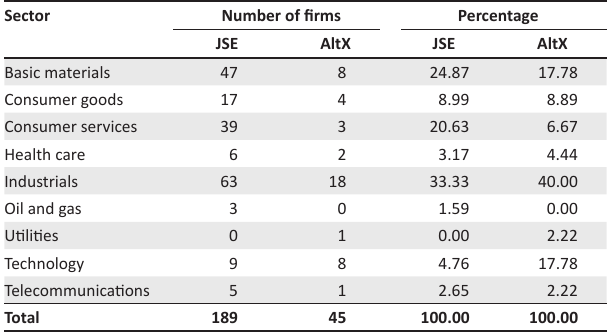
TABLE 2: Distribution of sampled firms by sector classification (Johannesburg Securities Exchange and Alternative Exchange firms).